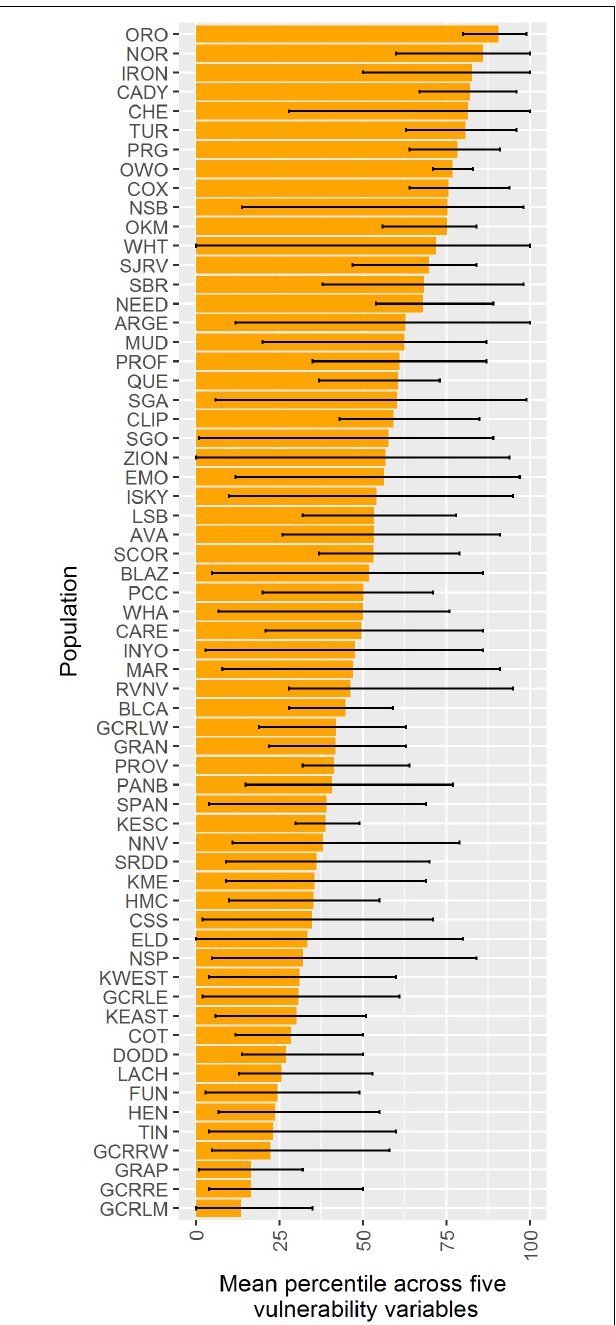
FIGURE 9 | Comparison among 62 desert bighorn populations of overall vulnerability to climate change based on five characteristics: genetic diversity (measured as allelic richness), genetic isolation, geographic isolation, mean forward climate velocity (for RCP4.5 emissions scenario), and maximum elevation. For each characteristic, we converted population values to percentiles (with higher percentiles associated with greater vulnerability). Boxes extend to the mean percentile value for each population across all size variables; whiskers show minimum and maximum percentile across the five characteristics for each population. Populations are sorted top to bottom from highest mean percentile (i.e., greatest overall vulnerability) to lowest. See Table 1 for full population